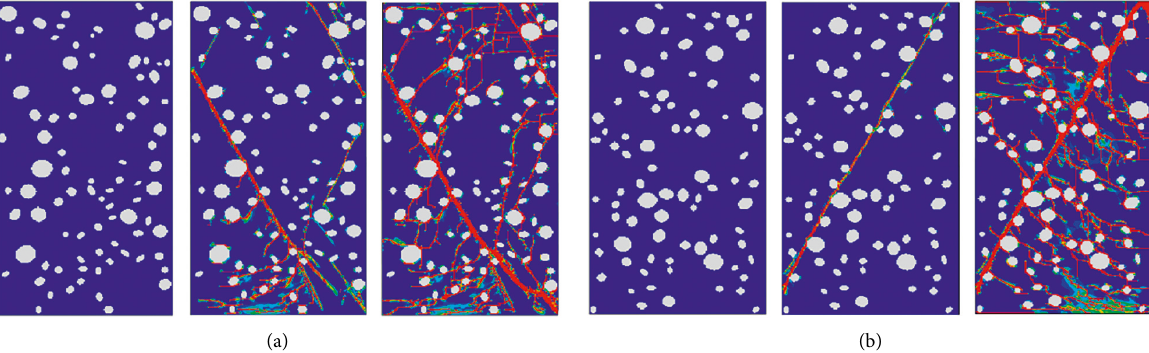
Figure 12: Simulation diagram of prismatic compression fracture extension. (a) RCA-0%. (b)